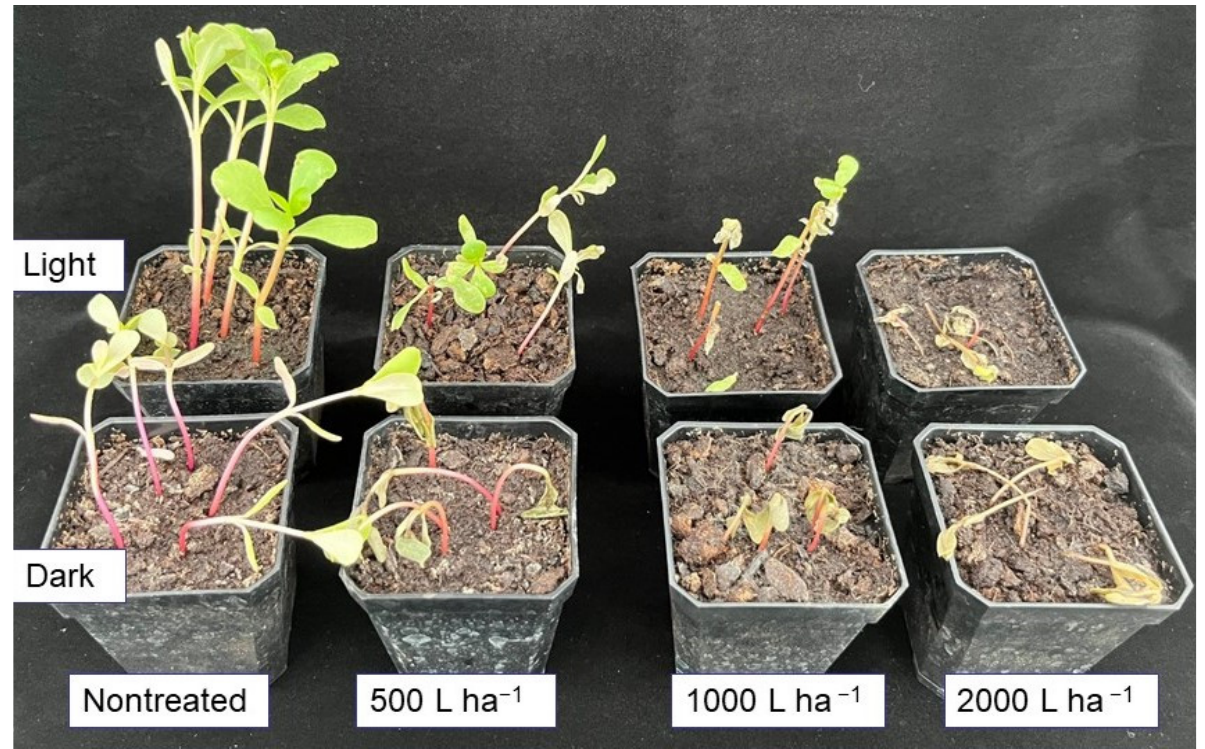
Figure 6. Common purslane control following the application of wood vinegar at 5 days after treatment under light and dark conditions. Table 2. Common purslane control following the wood vinegar application at 1 and 3 DAT under light